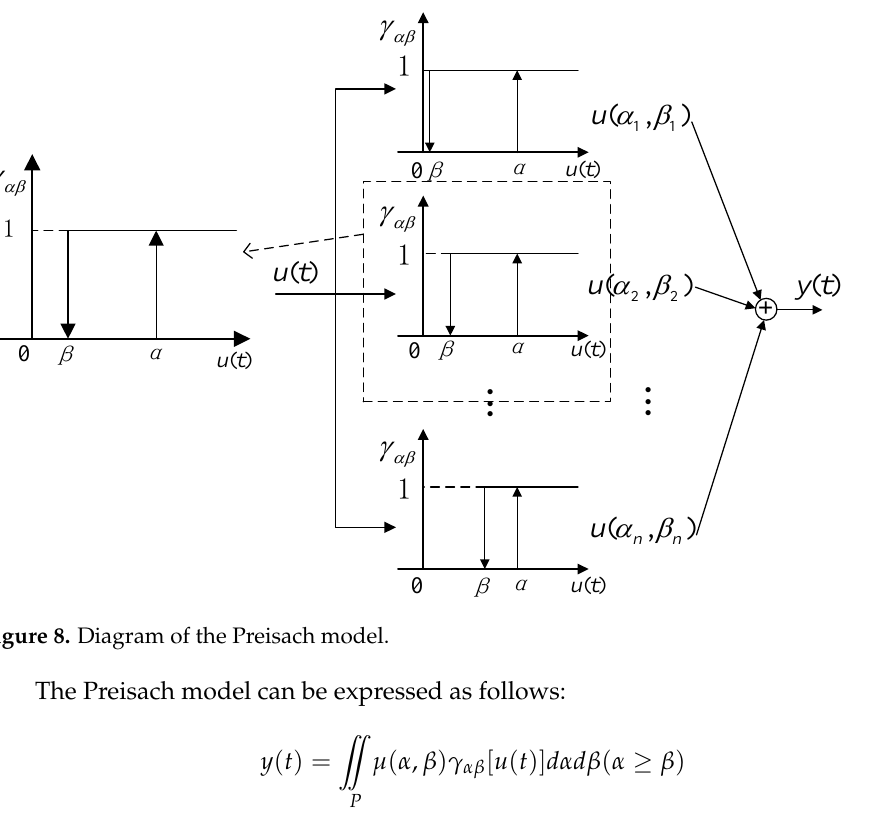
Figure 8. Diagram of the Preisach model.